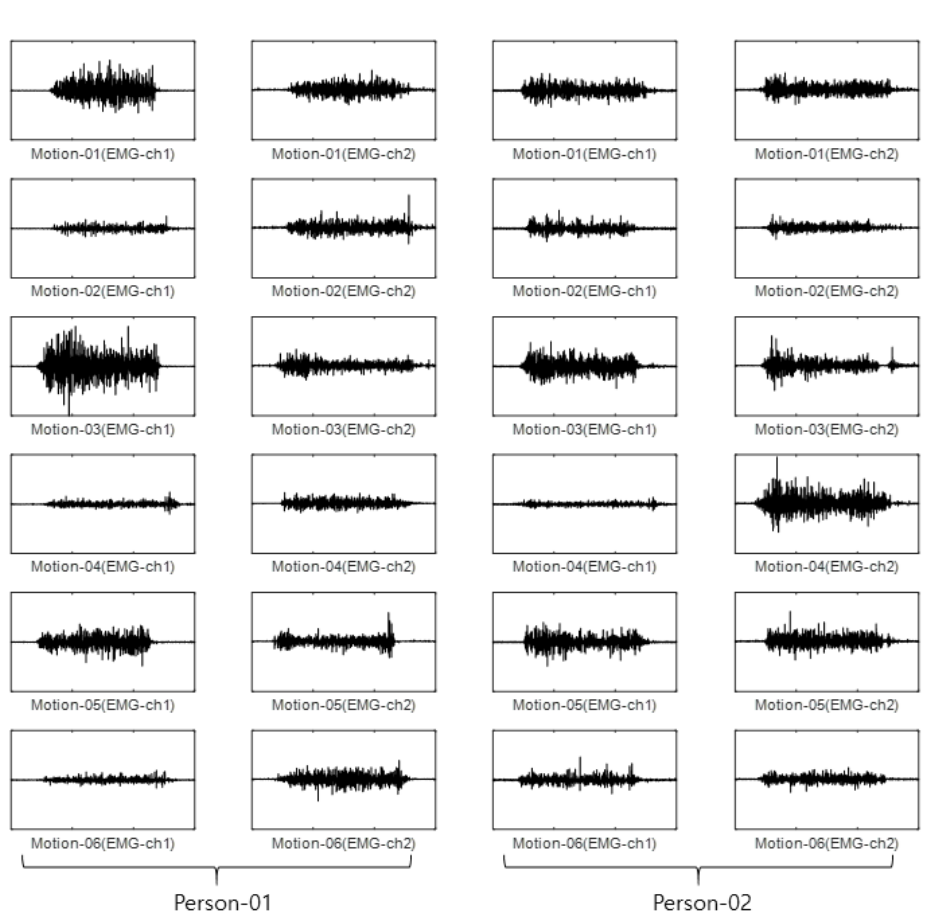
Figure 11. Some examples of CU-EMG-ECG database. Table 5. Accuracies on Test data of CU-EMG-ECG dataset.